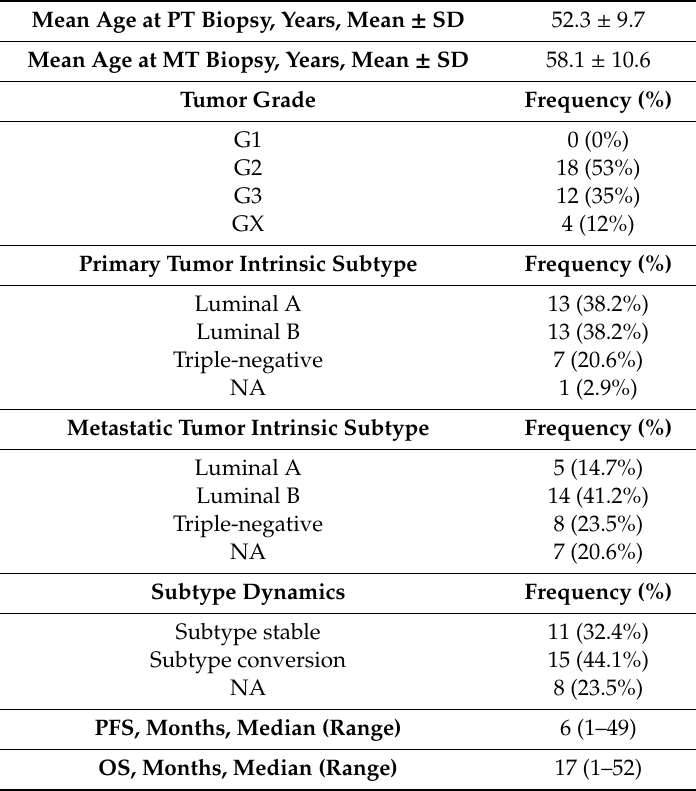
Table 1. Patient and tumor characteristics.